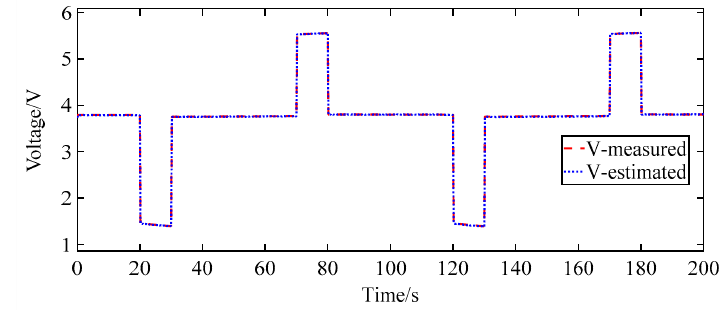
Figure 7. The voltage response comparison curve.